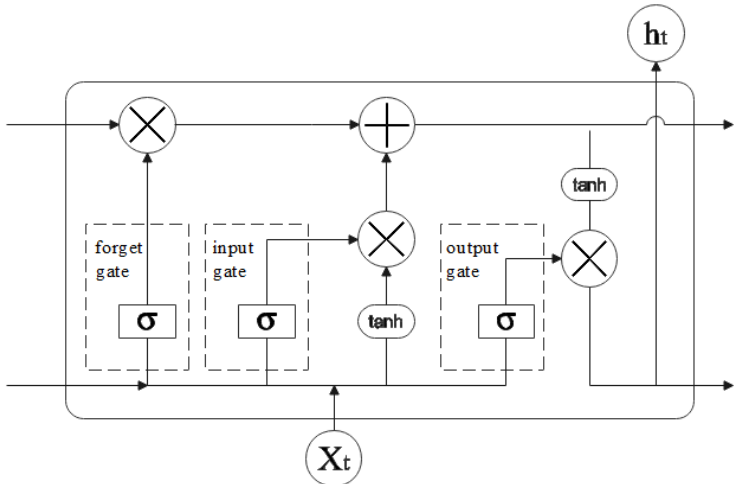
Figure 1. LSTM neural network structure.